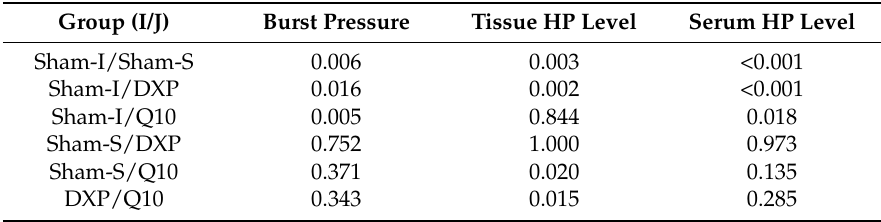
Figure 5. Error bars represent the burst pressure values of all groups. Table 4. The post hoc test results of the burst pressure level values and biochemical analysis findings. The Tukey Multiple Comparisons test, p < 0.05 (HP: